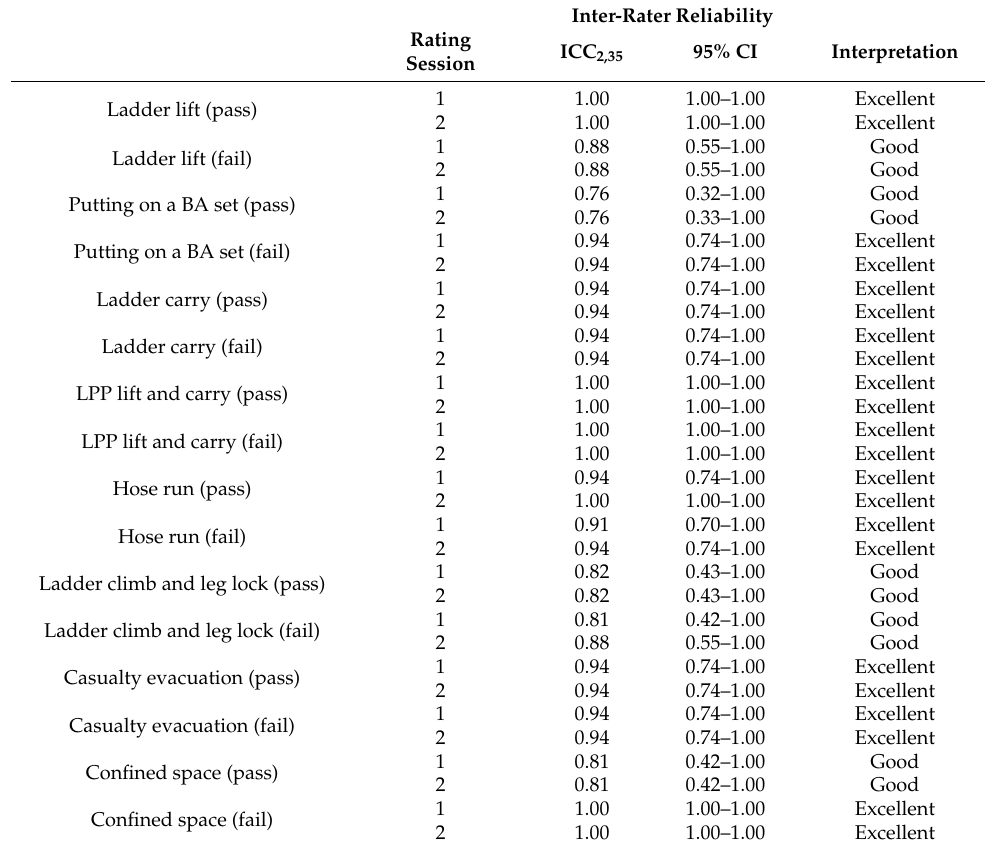
Table 3. Inter-rater reliability of each individual screening test video over two rating sessions. ICC = Intraclass correlation coefficients, CI = Confidence